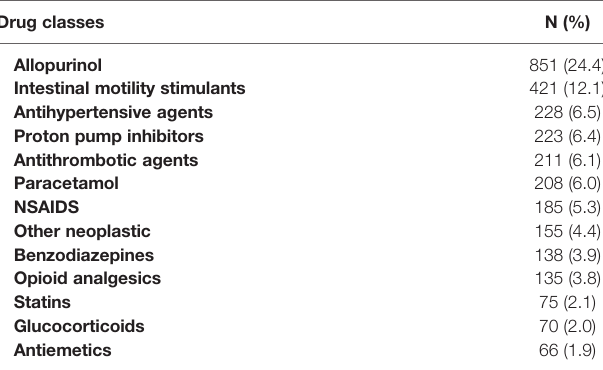
TABLE 2 | Description of drug classes concomitant with TKI exposure (issued within the day of fi rst TKI prescription) in the 3480 incident “ CML ” subjects with at least 2 dispensations of TKI, 2011-2014, France.